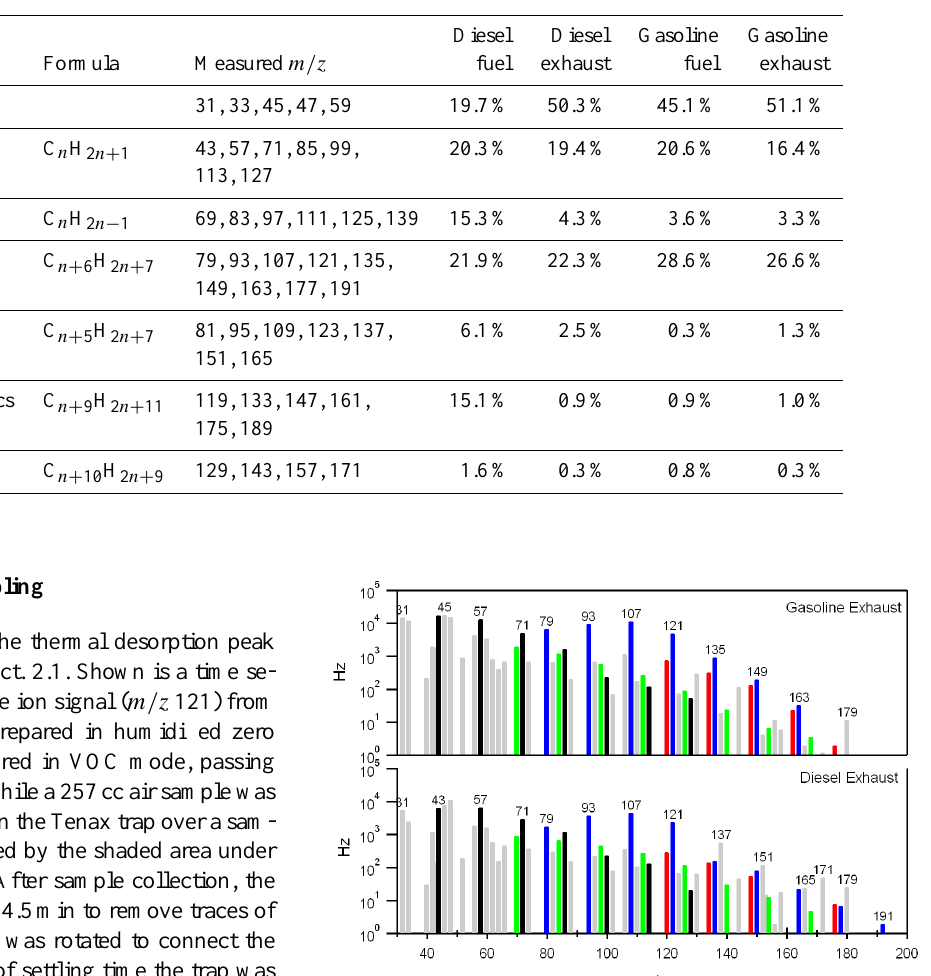
Table 2. Comparison of fuel and exhaust composition at 80Td.